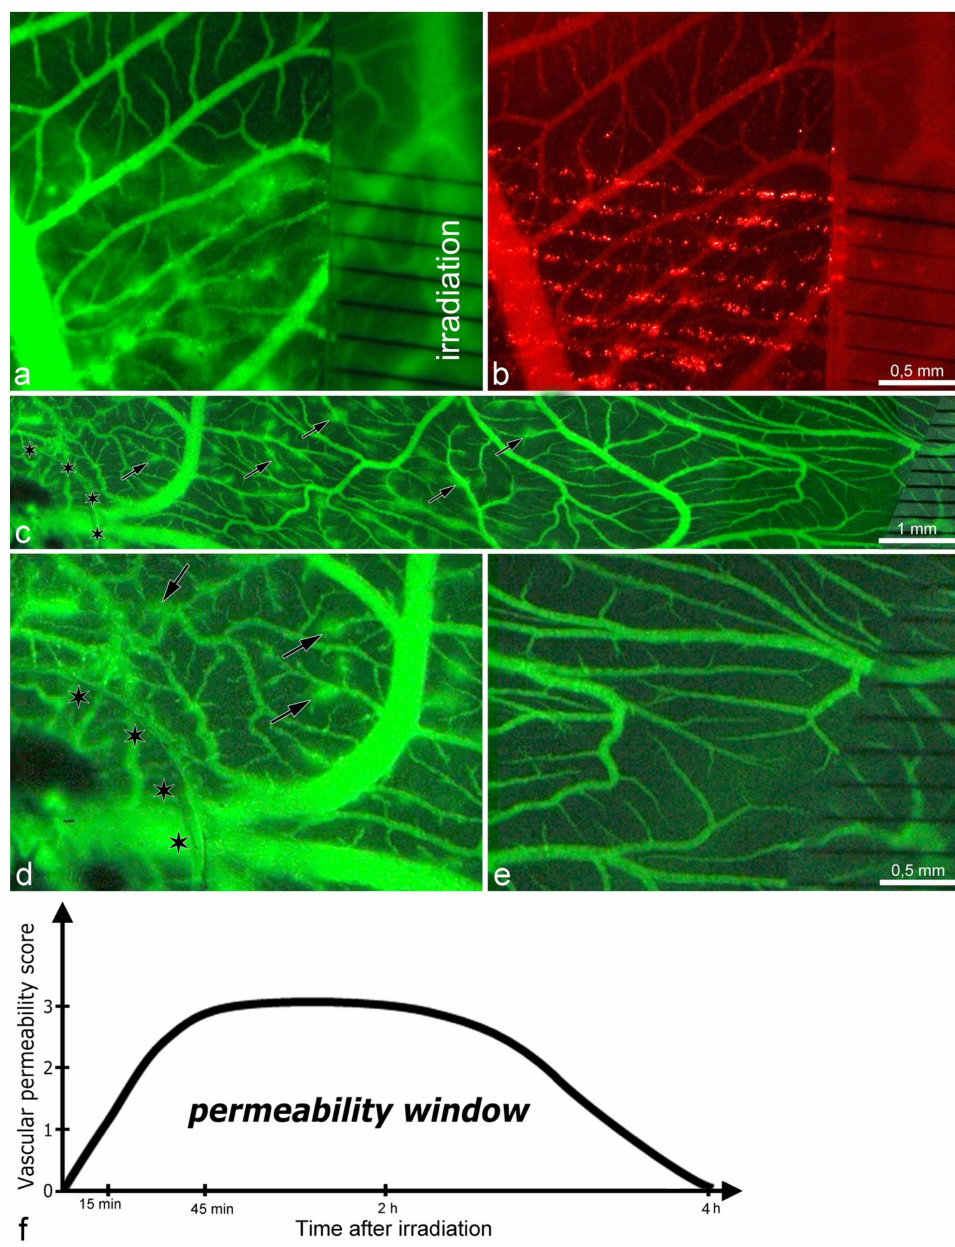
Figure 1. Images from intravital microscopy showing increased vascular permeability in CAM after exposure to MRT peak doses of 75 Gy; ( a , b ): normal CAM vasculature; ( c – e ): vasculature after VEGF treatment. Note: ( a ) forty-five minutes after exposure to MRT, the vascular permeability is increased, as demonstrated by the extravasation of FITC-dextran (green-fluorescent halos around the blood vessels). Conversely, in ( b ), the microspheres did not diffuse into the surrounding tissue but remained affixed as red-fluorescent dots along the microbeams path. Left side: ( c ) at the site of VEGF application (asterisks indicate the edge of the Thermanox ® coverslip), the vascular permeability increased as early as 10 min after MRT, as shown by the halos of extravasated FITC-dextran (some marked by arrows). Right side: in the non-treated zone, no such signs of increased vascular permeability were observed simultaneously. Images ( d , e ): parts of ( c ) at higher magnification. Image ( f ): schematic representation of the vascular permeability window after 75 Gy of MRT. The score: (0) = no FITC extravasation; (1) = small non-confluent FITC “halo” surrounding the capillaries; (2) = FITC “halos” start merging but they are not completely confluent; (3) = the “halos” are completely confluent. In ( a – e ), black stripes on the radiochromic film indicate the path of the